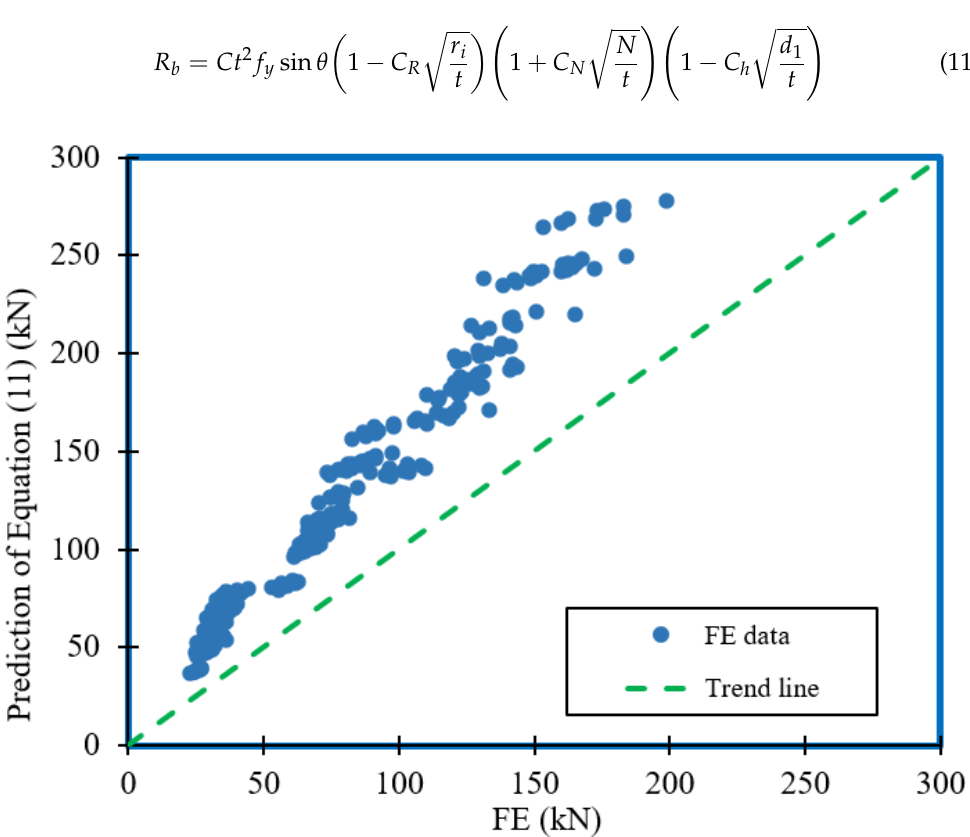
Figure 20. Comparison of parametric results and codified Equation (Equation (11))